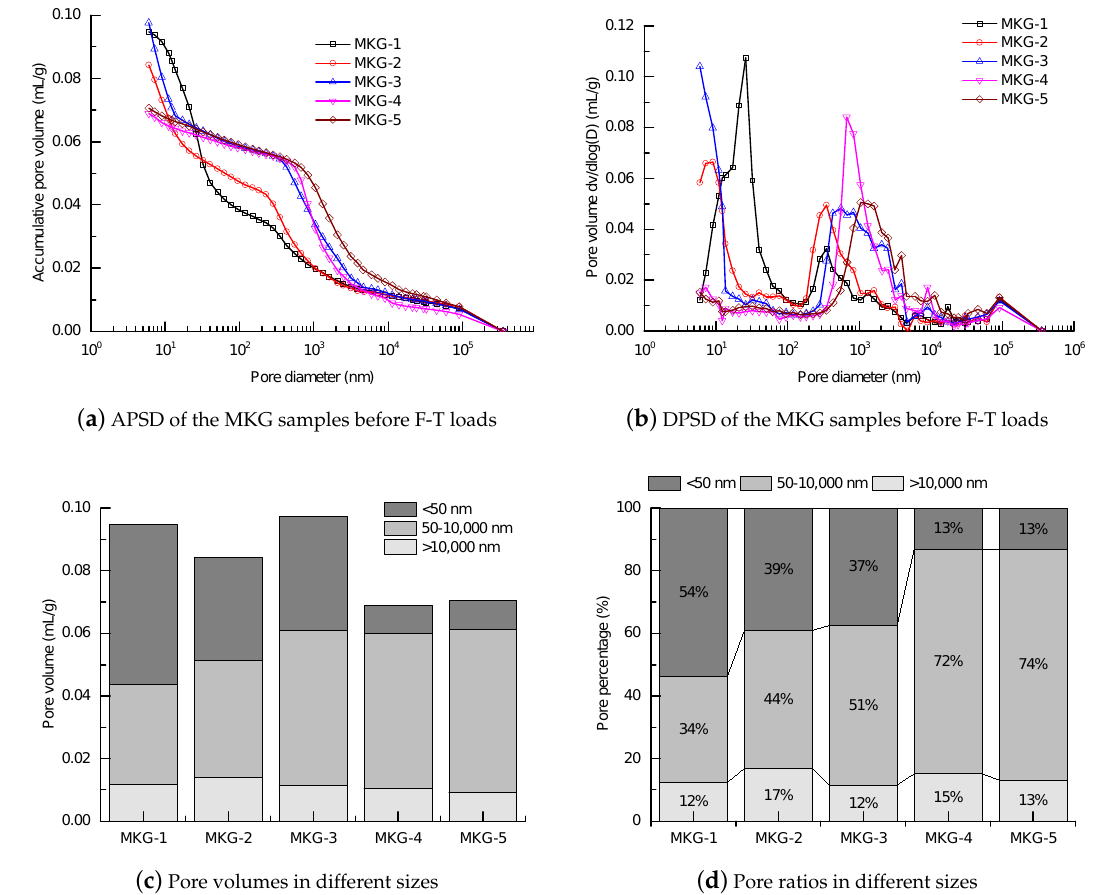
Figure 2. Pore structure of the MKG mortars before freezing-thawing (F-T) loads: ( a ) accumulative pore size distribution (APSD) spectra; ( b ) differential PSD (DPSD) spectra; ( c ) pore volumes in different sizes; and ( d ) pore ratios in different